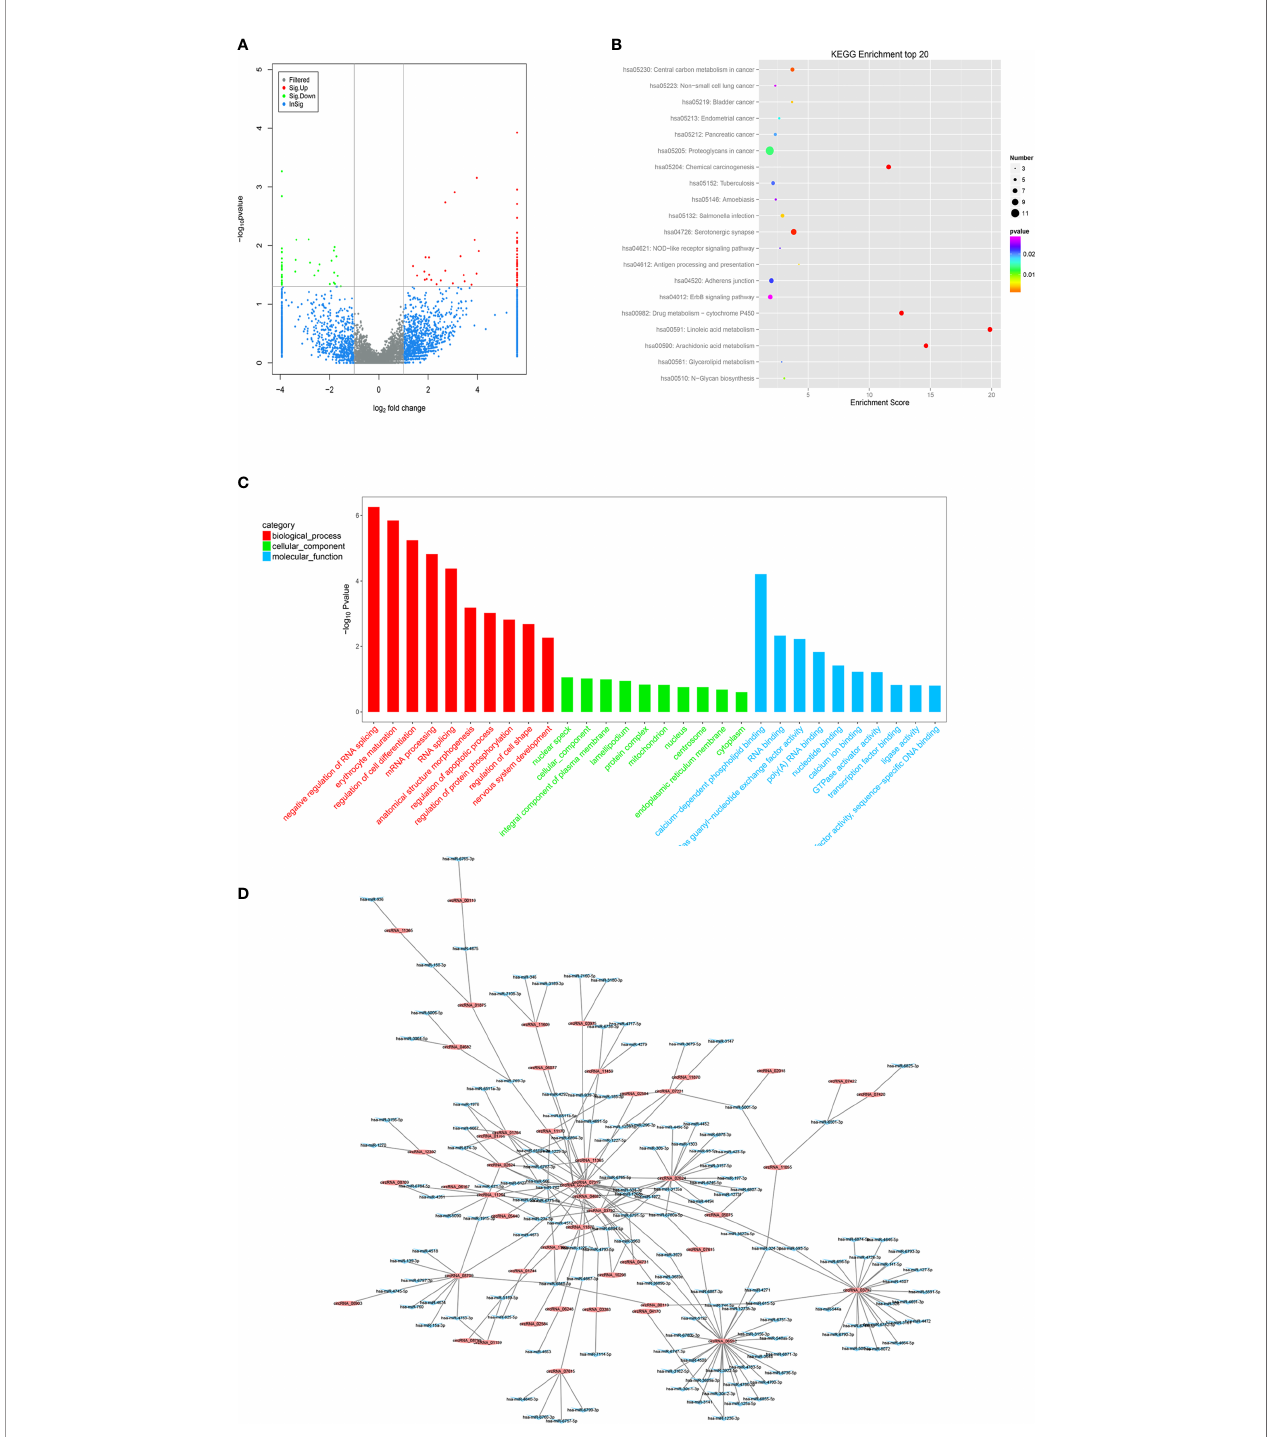
FIGURE 6 | Pro fi ling of circRNAs in GC tissues compared to adjacent mucosa. (A) Volcano plot shows tp-regulated and down-regulated circRNAs in cancer vs normal group. Higher expression levels are indicated by “ red ” , lower expression levels are indicated by “ green ” , and no signi fi cant difference is indicated by other colors. (B) KEGG analysis of circRNAs in cancer vs normal group. (C) GO analysis of lncRNAs in cancer vs normal group. (D) circRNA-miRNA target interaction network